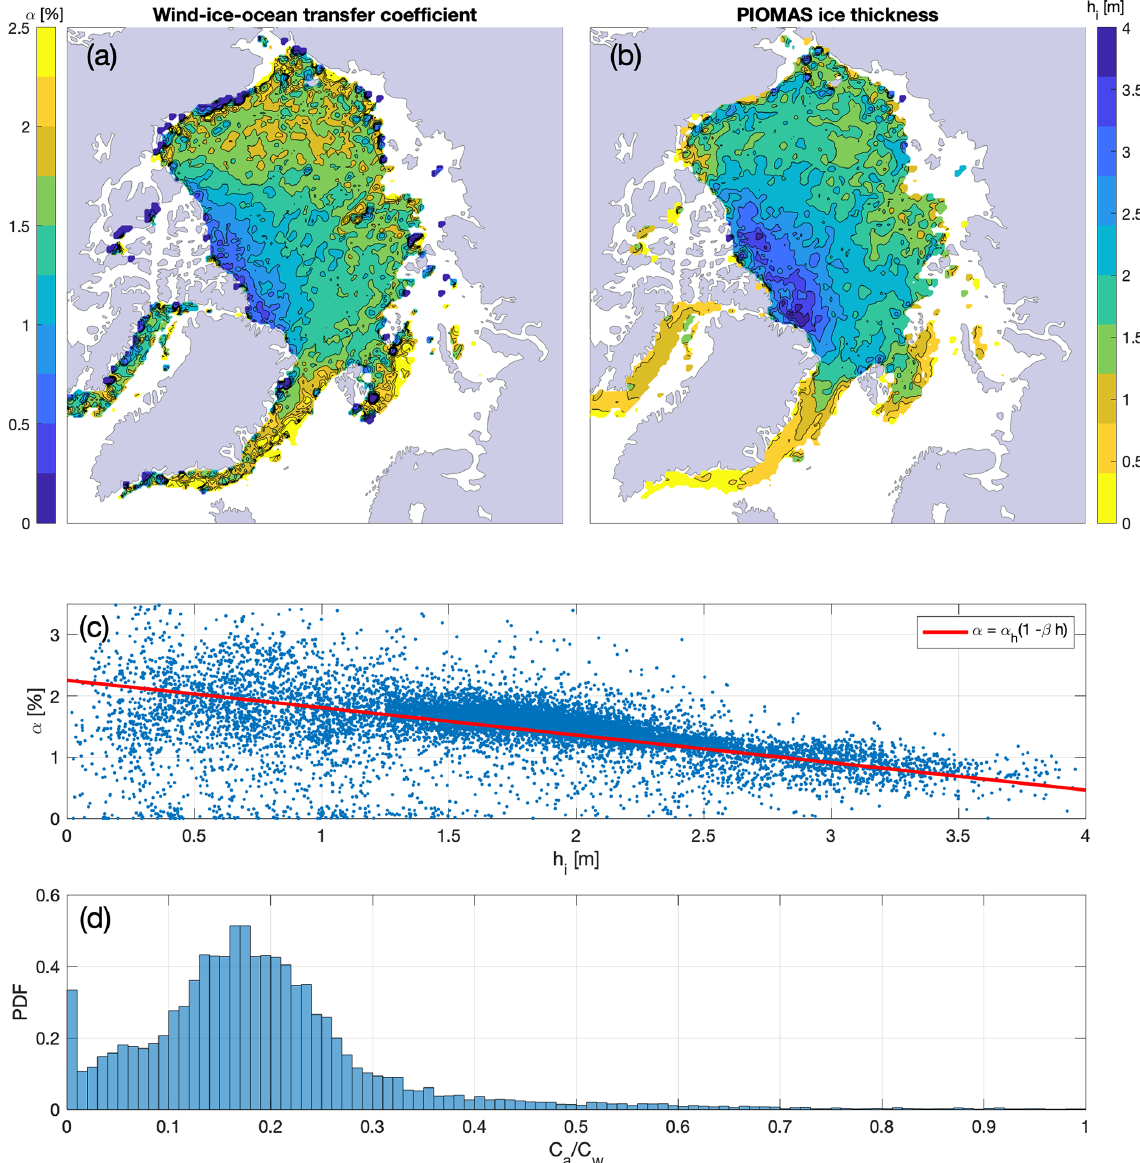
Figure 4. Spatial distribution of (a) wind–ice–ocean transfer coefficient calculated from a local linear fit between the IABP buoy ice velocity and the ERA5 10m wind velocity and (b) PIOMAS ice thickness (at buoy location). For each grid cell, all data over the 1979–2019 period within a 3 × 3 search array centered on each grid cell are considered. These fields represent year-round climatological averages. (c) Scatter plot of the magnitude of the transfer coefficient against ice thickness; the red line is the best linear fit. (d) Distribution of the equivalent ratio of atmospheric to ocean drag coefficients, C a /C w